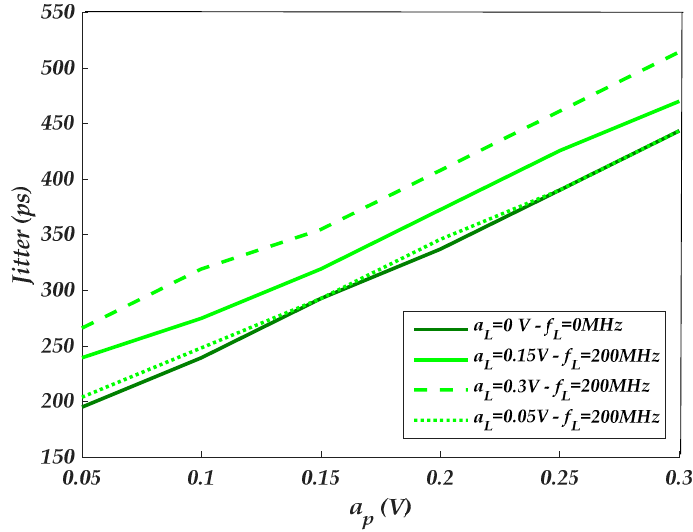
Figure 14. Pre-driver-stage parametric plot of the IO buffer amplitude-dependent jitter TF as the pre-driver stage amplitude is swept for different V ddq ( t ) supply